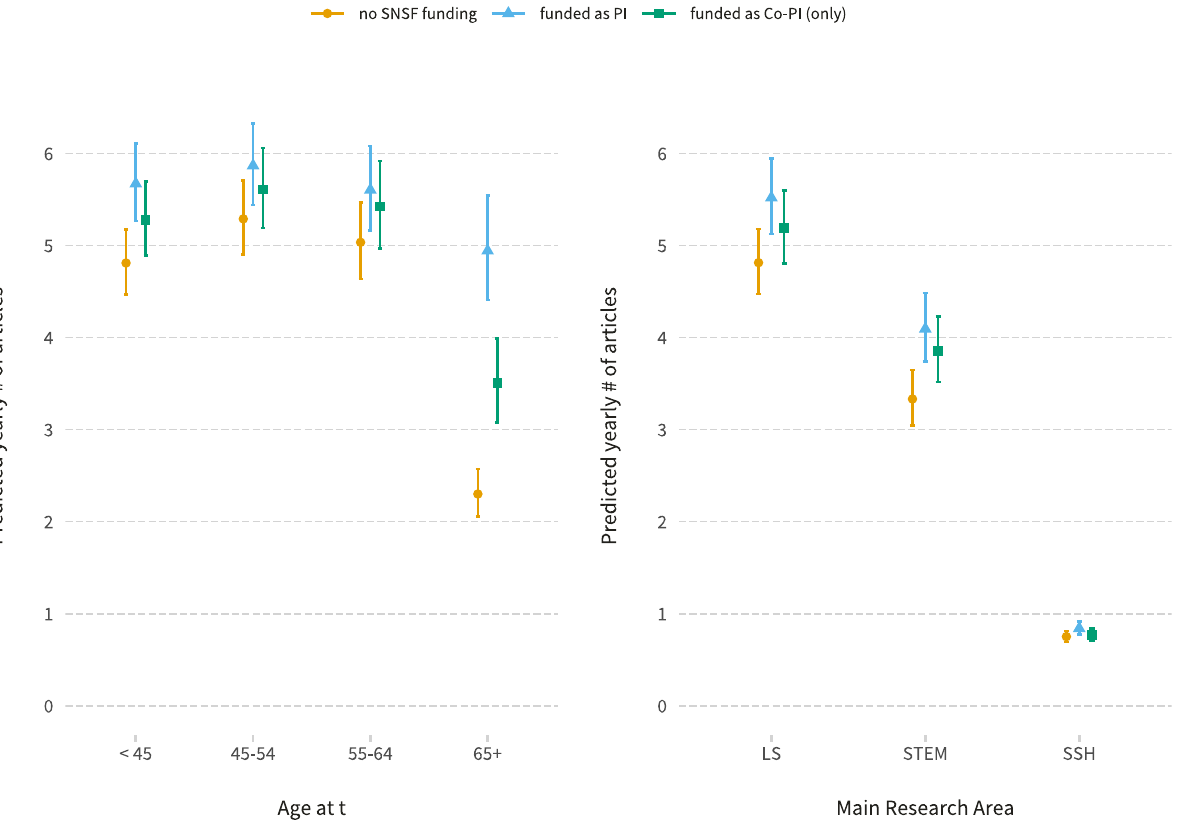
Fig. 2 Predicted yearly number of articles depending on whether or not the researchers were treated (as PI or Co-PI) or not (no funding), given the researcher ’ s age group (left) and the research fi eld (right). To predict the article count the baseline confounding variables were fi xed to Year 2015 – 19, Male, Evaluation Score Score AB-A, University, LS in the age interaction model and age lower to 45 for the fi eld interaction model. We see a signi fi cant positive percentage change of 18% for the youngest age group among PIs (<45) and 115% for the most senior researchers (>65) compared to no SNSF funding. Additionally, the effect of funding is largest for STEM researchers (23% more articles as PI compared to unfunded researchers. The effect in LS and SSH is less prominent, + 15% and + 12%,